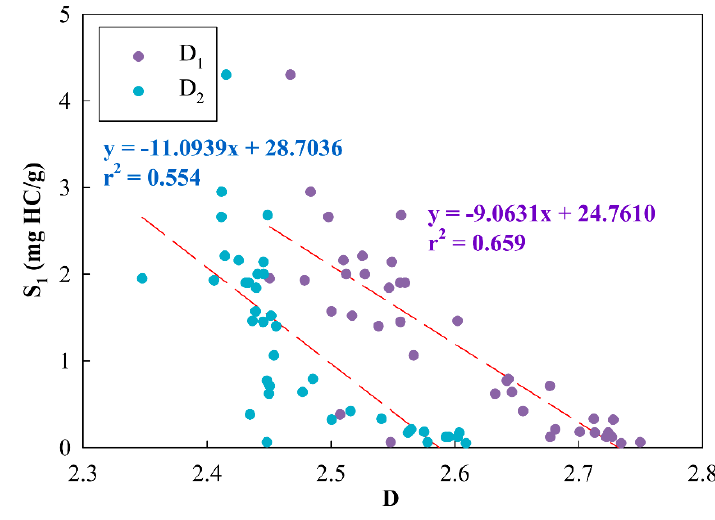
Figure 11. The 2D scatter plot of free hydrocarbon content versus fractal dimensions.